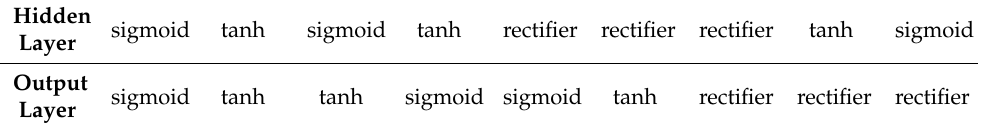
Table 4. Activation functions used in the deep neural networks